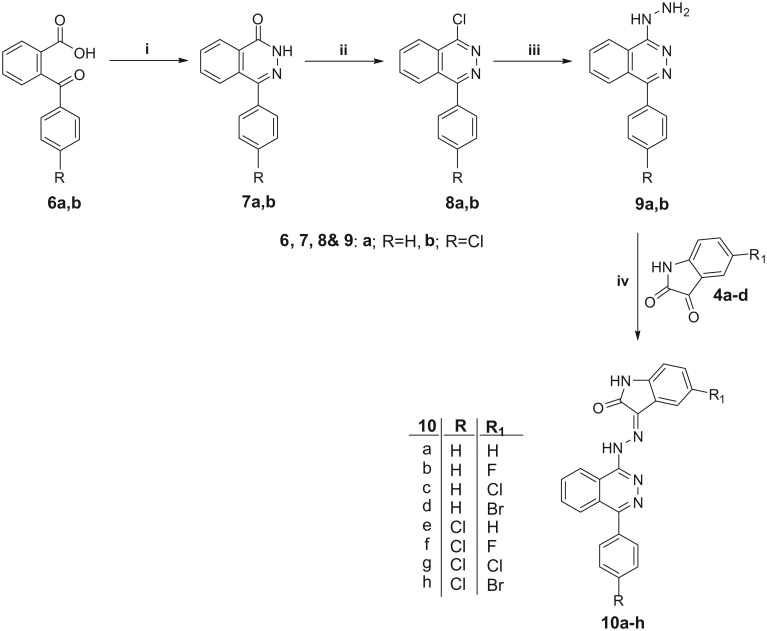
Reagents and conditions: i, NH2NH2.H2SO4/NaOH/reflux 1 h; ii, POCl3/N,N-dimethylaniline/reflux 6 h; iii, NH2NH2.H2O/EtOH/reflux 7 h. iv, EtOH/AcOH (catalytic)/reflux 1 h.